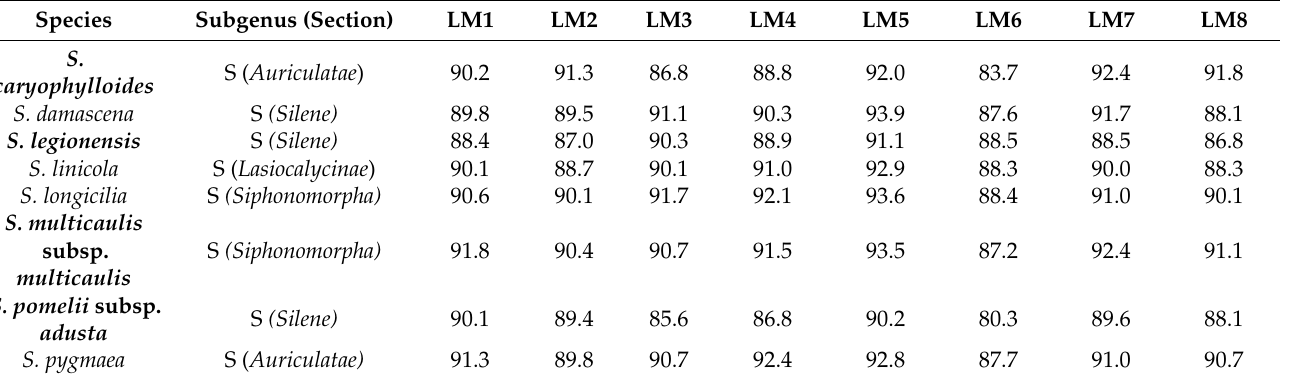
Table A3. Values of J index for the average silhouettes of each species with the eight lateral models: species giving higher values in model LM5 than in other models. In bold: species that did not reach the threshold value of 89.0 for the J index estimated as the mean of 20 seeds. B: corresponds to S. subg. Behenantha ; S: corresponds to S. subg. Silene